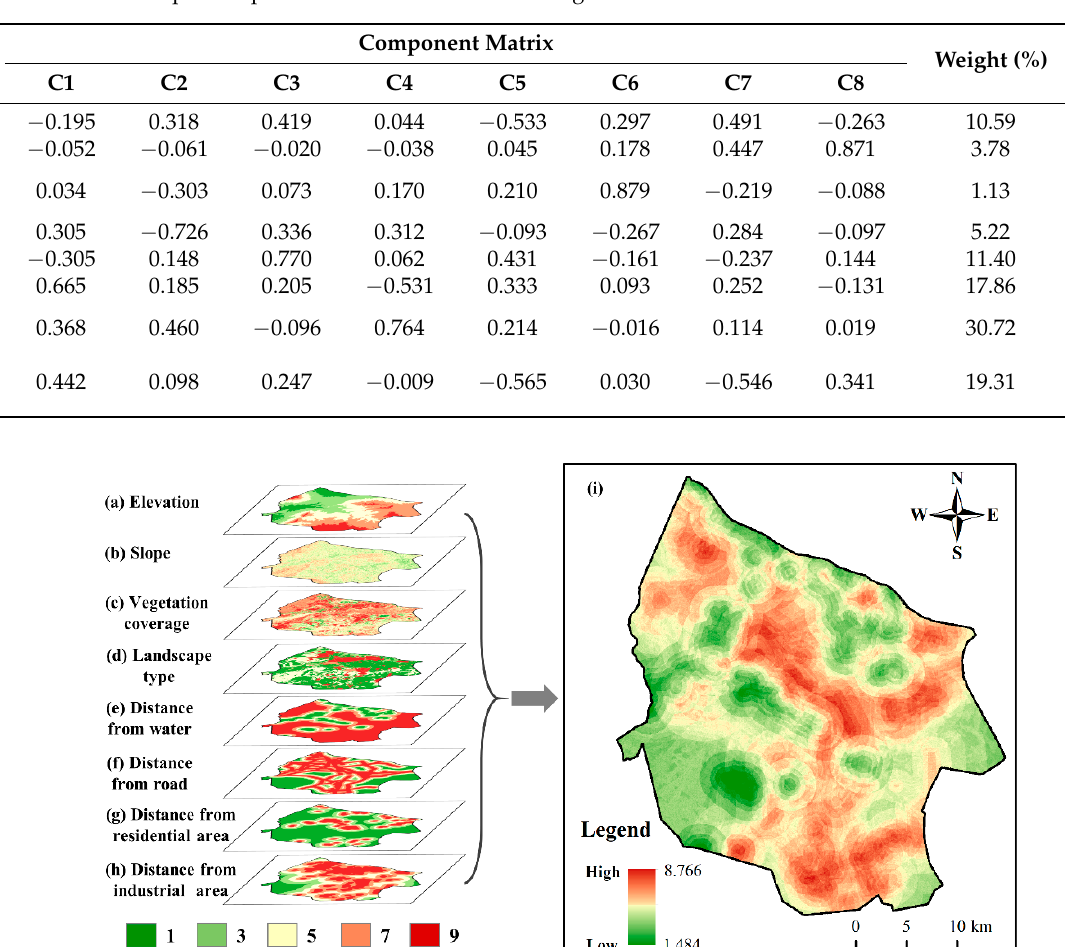
Table 8. Principal components load matrix and the weight of resistance factors.